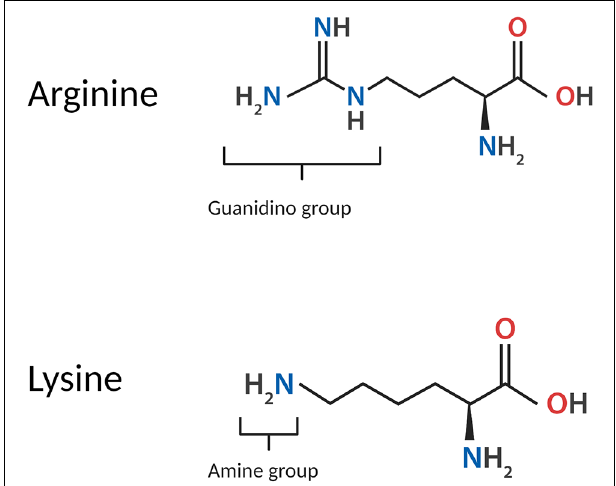
FIGURE 1 | Structure of the arginine monomer in comparison to